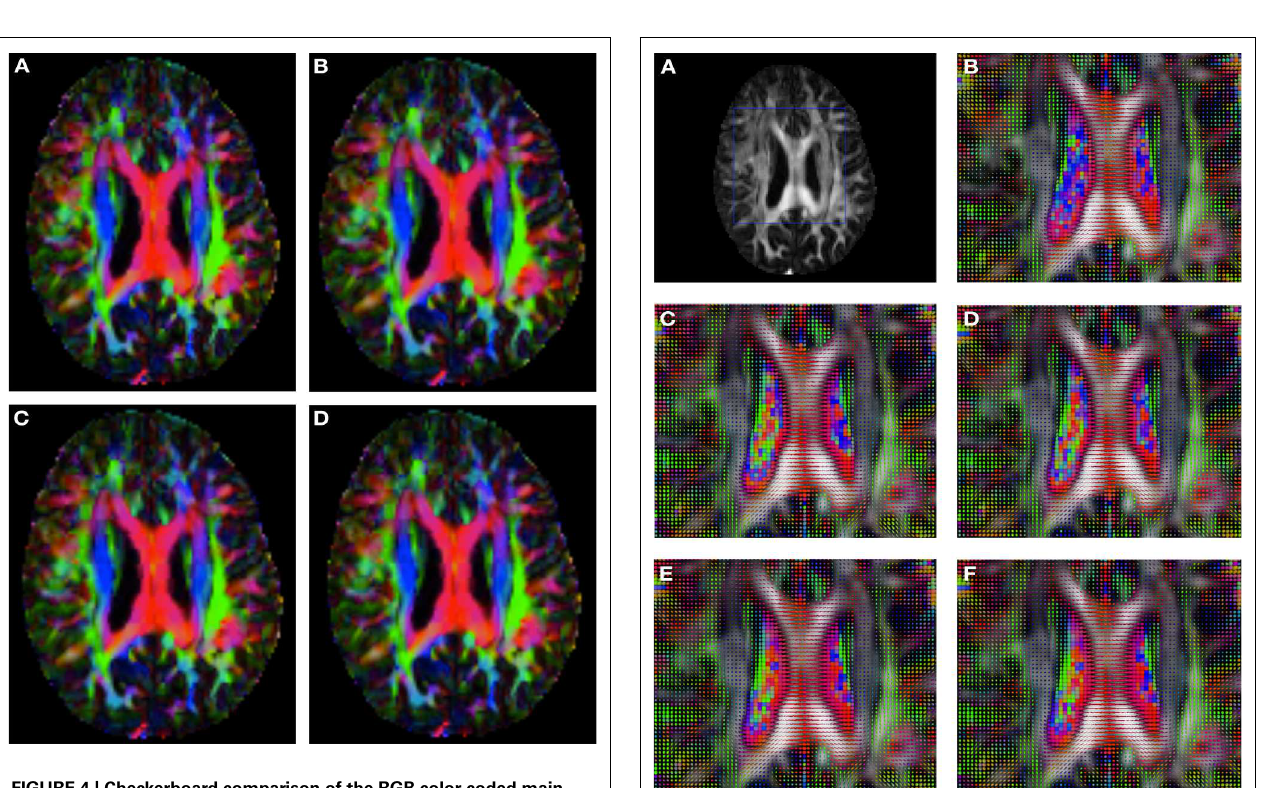
FIGURE 4 | Checkerboard comparison of the RGB color coded main diffusion direction between Subject3-2 and Subject3 registered to Subject3-2 using (A) FLIRT-volumes-SH. (B) FLIRT4D-AI. (C) MedINRIA-volumes-SH, (D) DTI-TK-volumes-SH.